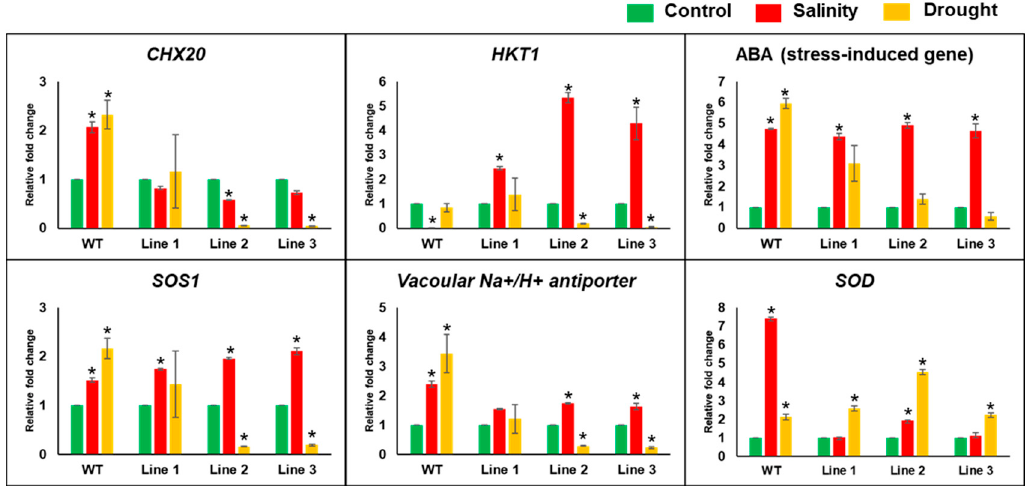
Figure 10. Gene expression analysis of CHX20, SOS1, HKT1, vacuolar Na + / H + antiporter, ABA stress-induced gene and SOD in WT and transgenic Arabidopsis subjected to salinity and drought stress. The bars represent the relative fold change ( ± SE, n = 3), while the asterisks indicate a significant difference from the control ( p < 0.05).